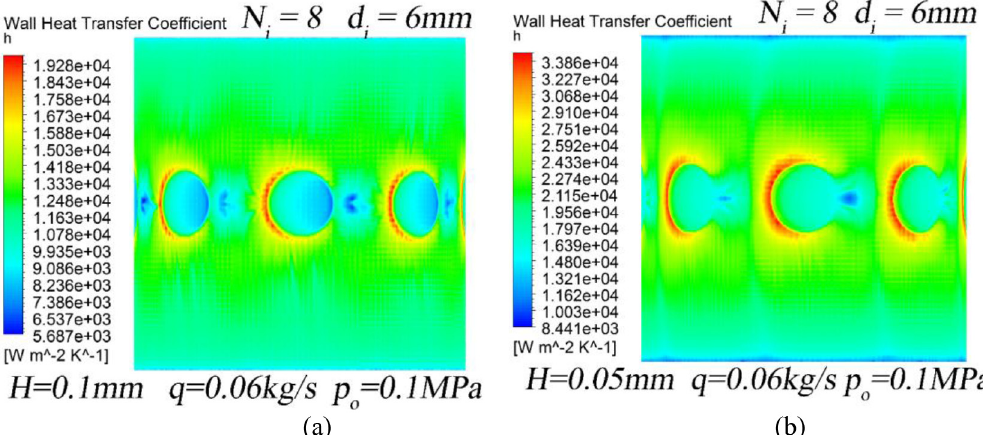
Fig. 15. Comparison of the heat transfer coef fi cient distribution between H=0.1mm and H=0.05 mm. (a) H=0.1 mm. (b) H=0.05